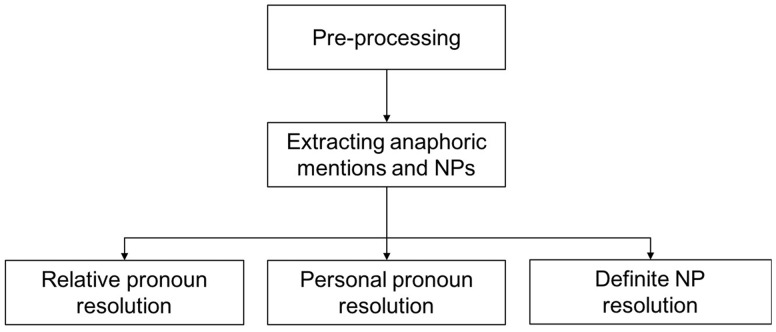
System architecture.